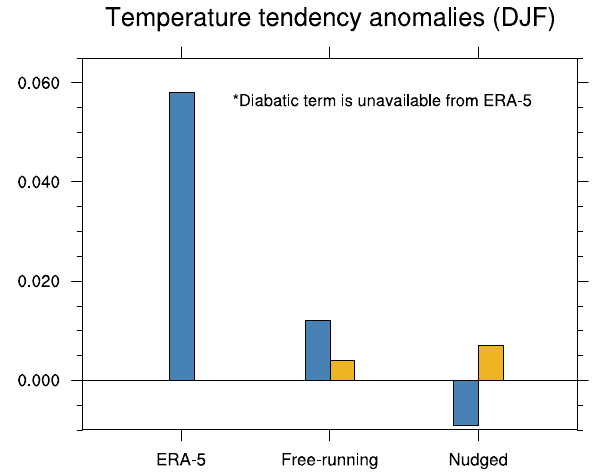
Fig. 2 Decomposition of temperature tendency anomalies in the Arctic mid-to-upper troposphere induced by BKS sea-ice loss. Bar plot of temperature tendency differences (K day − 1 ) averaged in winter (DJF) contributed by adiabatic heating/cooling due to residual vertical motion (blue) and diabatic processes (yellow) between BKS low- and high-SIC scenarios, averaged north of 65°N in mid-to-upper tropo- sphere (600 – 225 hPa), derived from ERA-5 reanalysis, WACCM-SC simulations without and with nudging technique